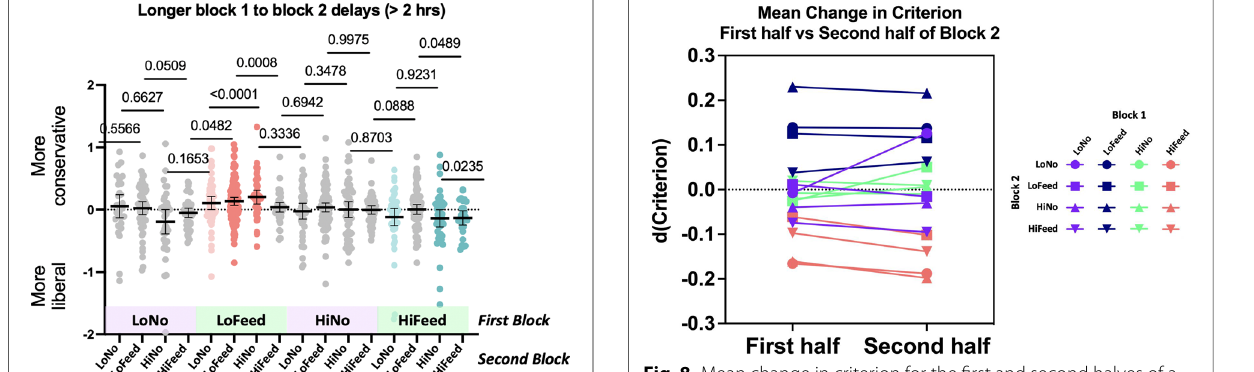
Fig. 8 Mean change in criterion for the first and second halves of a block of trials